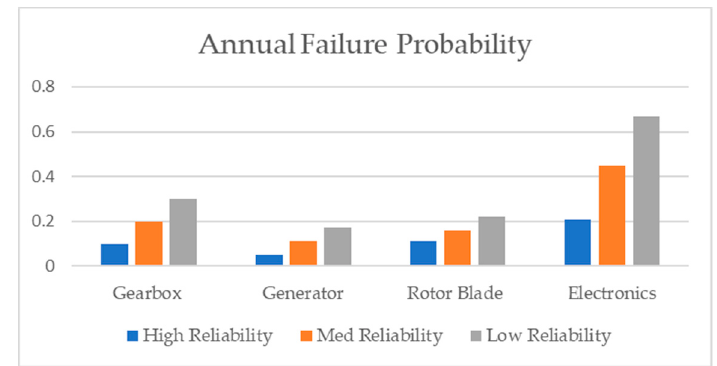
Figure 4. Annual failure probability for subcomponents (adapted from [29]).